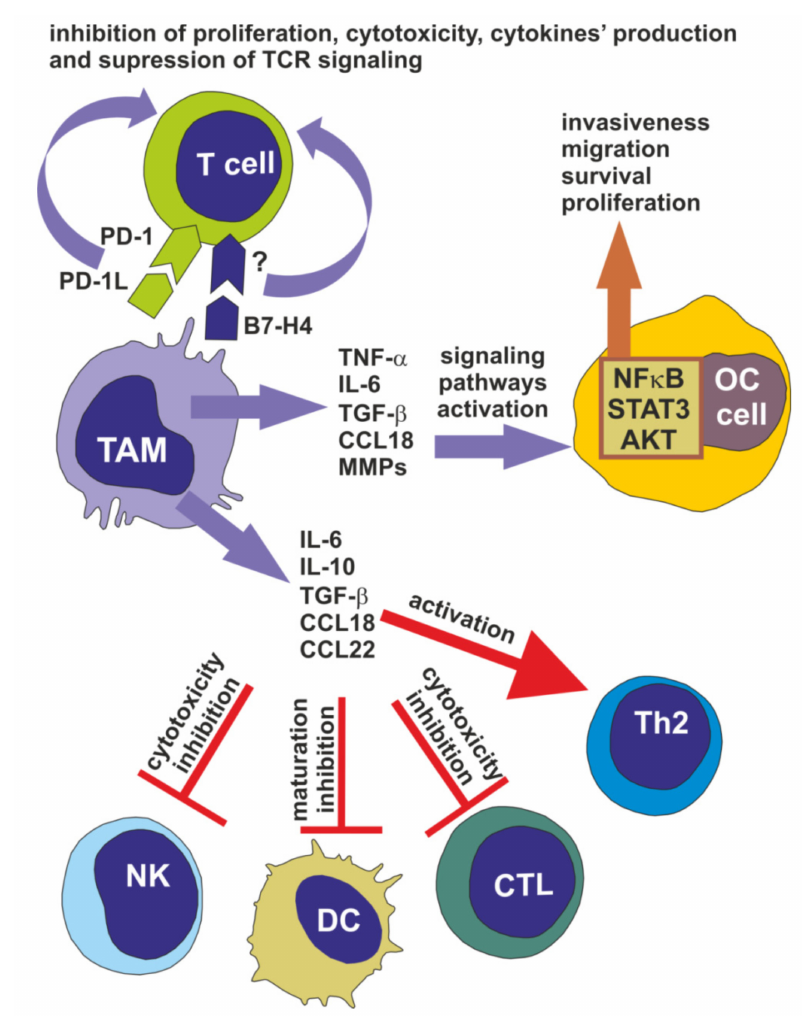
Figure 2. Involvement of M2-like TAMs in the progression of ovarian cancer. TAMs release a variety of soluble factors responsible for the activation of various signaling pathways in ovarian cancer (OC) cells, promoting their survival, proliferation, migration and invasiveness. Cytokines released by TAMs impair the activity of immune cells, including dendritic cells (DC), natural killer (NK) cells, and cytotoxic T cells (CTL), as well as induce the activity of Th2 cells. Direct interaction of TAMs and T